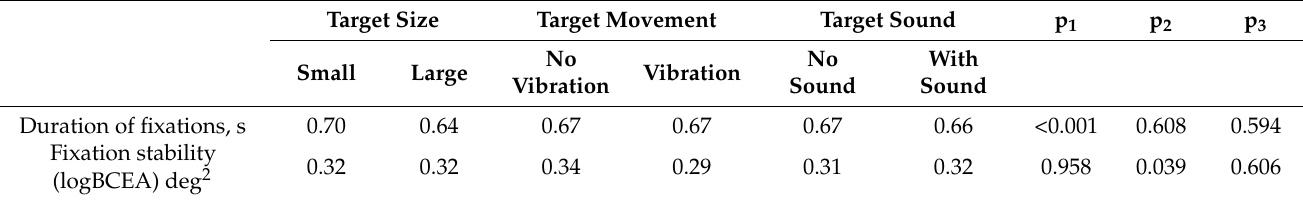
Table 3. Effect of stimuli features on oculomotor outcomes.